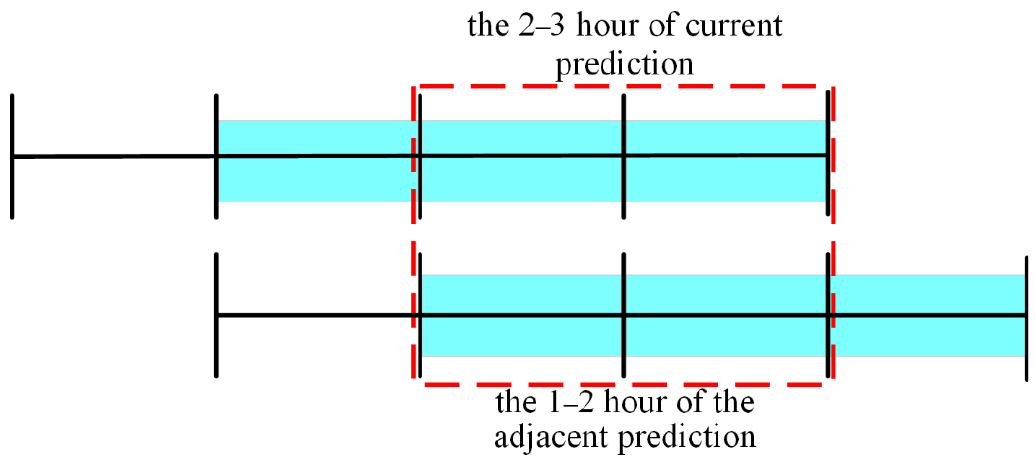
Figure 14. A 2–h arc overlap comparison of two adjacent ultrarapid orbits.